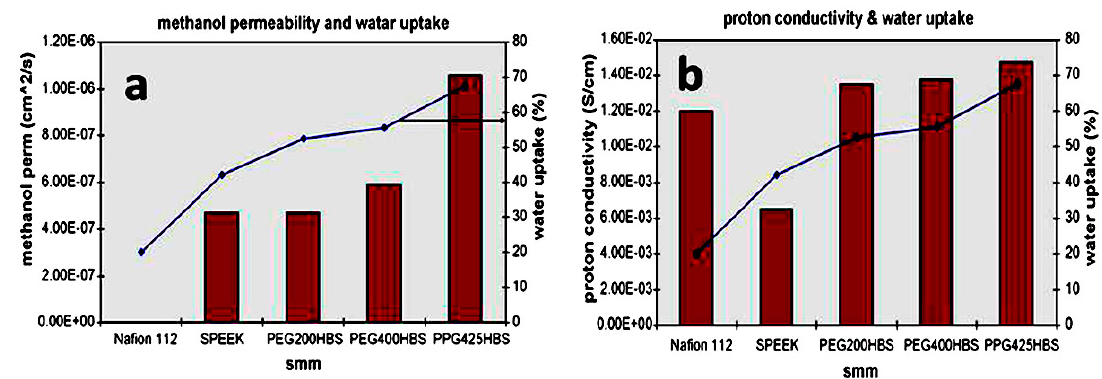
Figure 12. ( a ) Water uptake and methanol permeability of the blended membranes. ( b ) Water uptake and proton conductivity of blended membranes. Reproduced with permission from [96]. Copyright Elsevier, 2009.